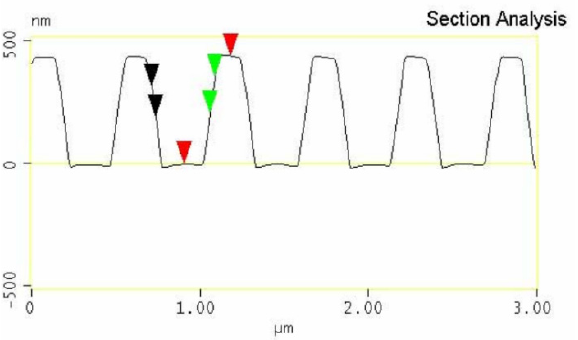
Figure 11. AFM measurement on a PW08 sample (section analysis).